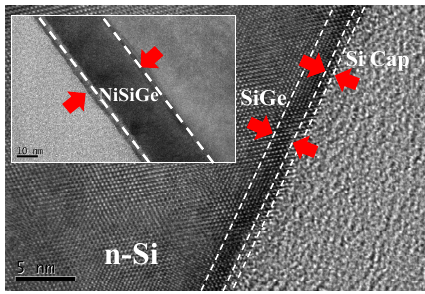
Figure 2. The cross ‐ sectional TEM images show the polycrystalline structure in the Si/SiGe/n ‐ Si lattice interface image. The inset figure shows the NiSiGe Schottky junction through MWA at 390 °C.